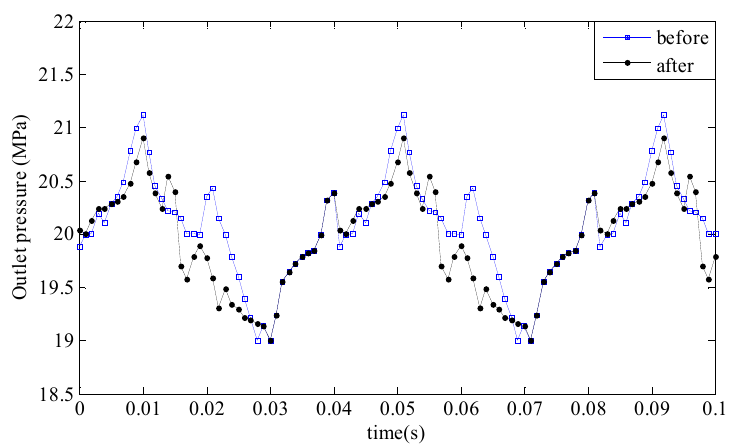
Figure 15. Comparison of outlet flow in the experiment before and after the optimization design.